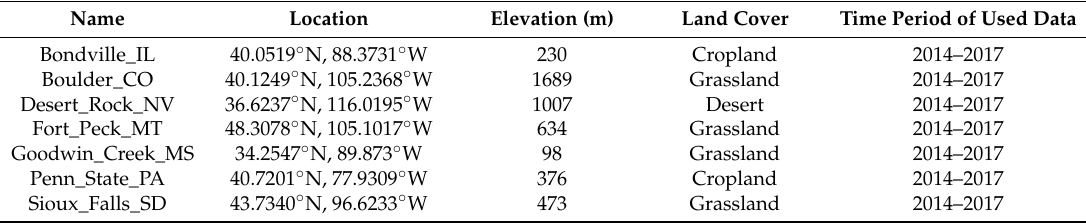
Table 1. Information of sites in the Surface Radiation Budget Network (SURFRAD)